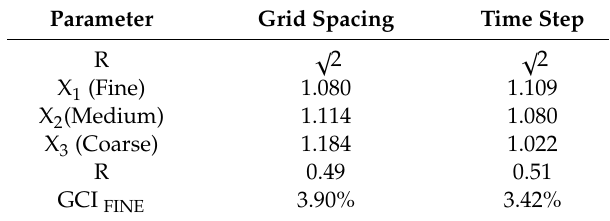
Table 3. Uncertainty Studies for Heave Transfer Functions ( ω e = 7.59_Mono_V = 3.4 m / s).